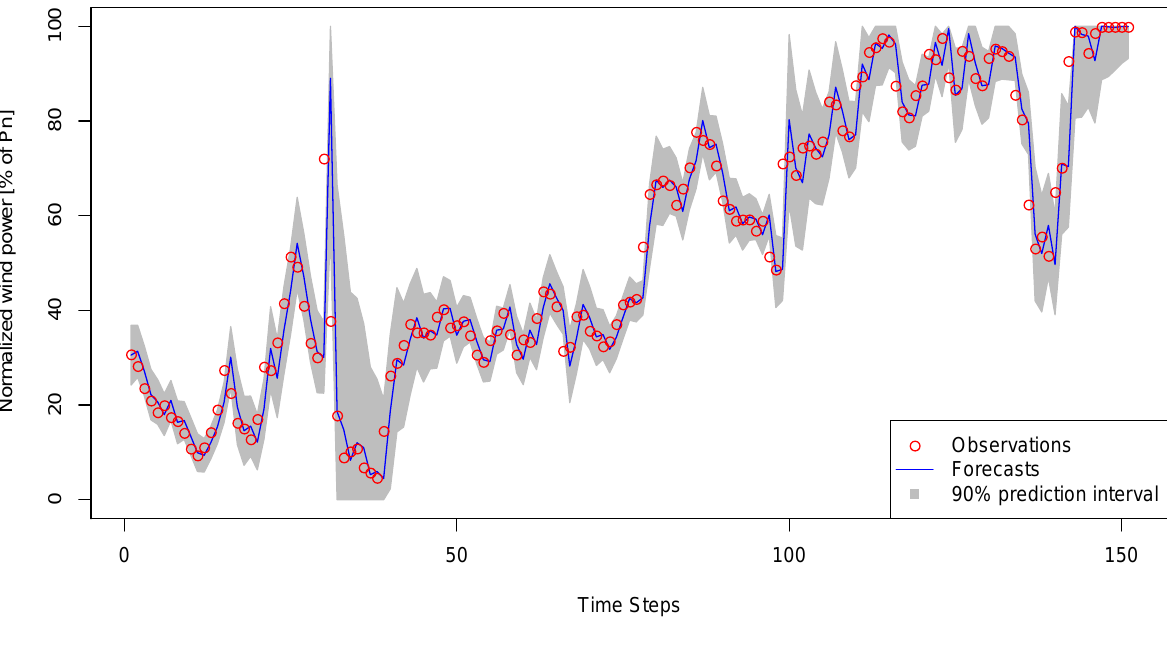
Figure 8. Example of time series of normalized wind power generation (red dots) along with one step-ahead forecasts (blue line) and the prediction interval of 90% coverage rate (shaded area in gray) defined with the two quantiles with nominal proportions 5 and